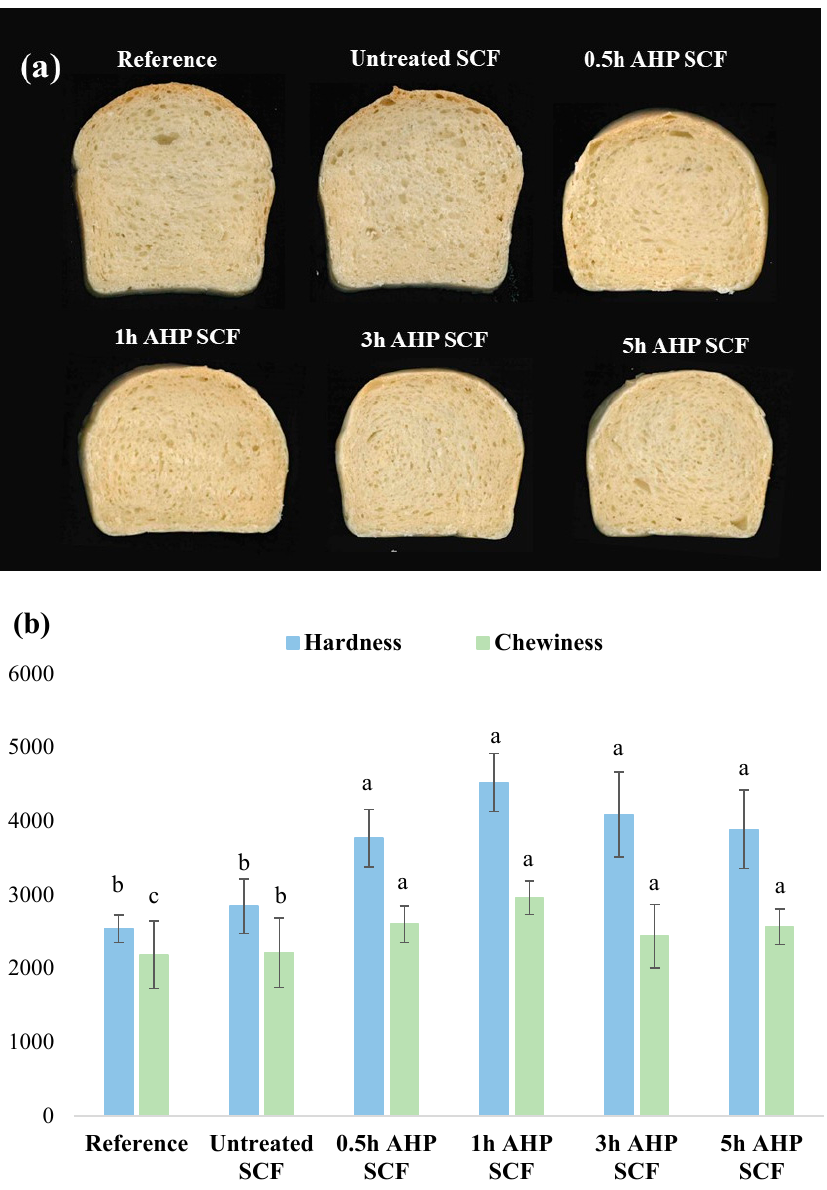
Figure 4. ( a ) Cross-sectional photographs illustrating the crumb appearance of bread samples. ( b ) Texture profile analysis (hardness and chewiness) of bread samples without SCF (reference), incorporated with 5% untreated SCF, and 0.5 to 5 h AHP SCF. Different letter represents a significant di ff erence within the same texture a tt ributes ( p < 0.05), where n = 6.